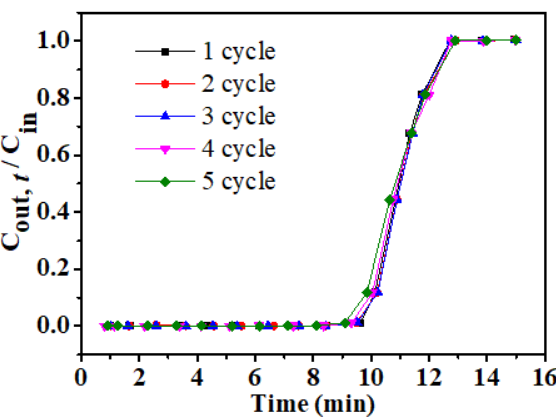
Figure 11. Adsorption breakthrough curves for dry L2 of rGOA-1 in the repeated cycles.